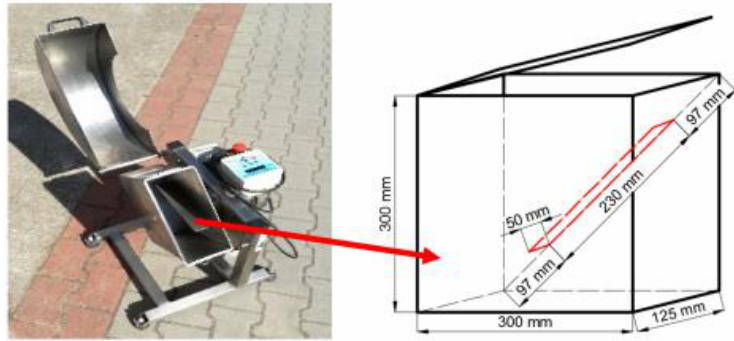
Figure 3. Device for testing mechanical durability with a rotating working chamber.